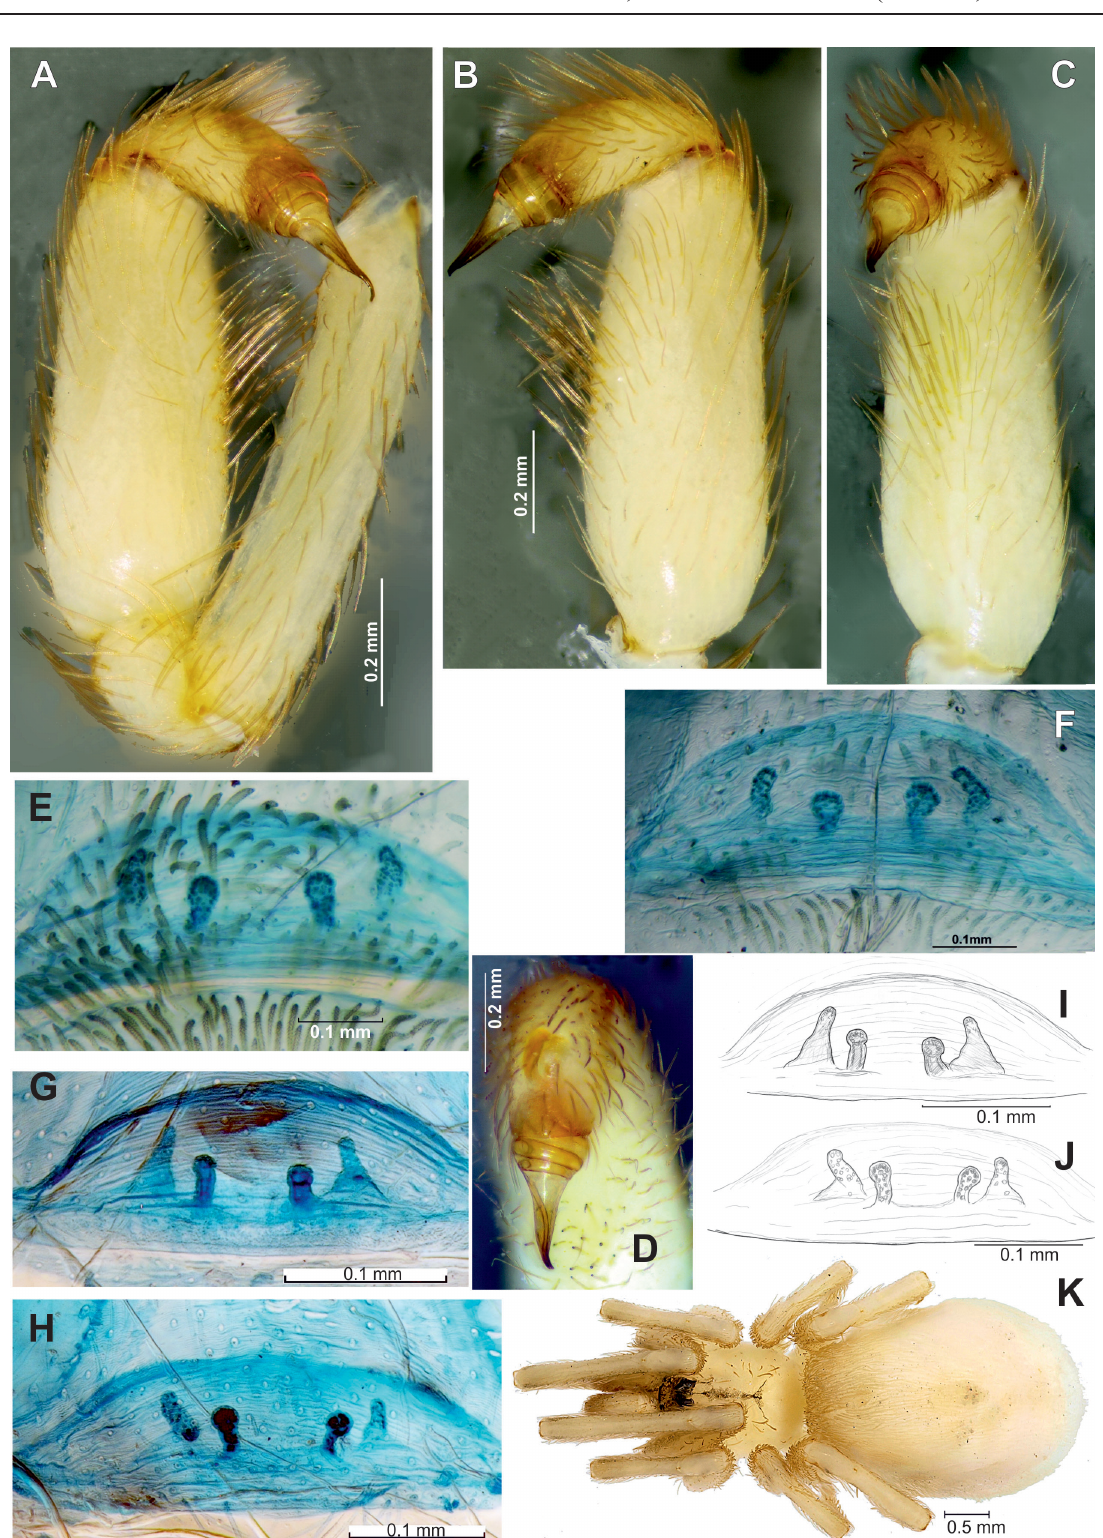
Fig. 35. Copulatory organs and somatic characters of Zaitunia ferghanensis sp. nov., paratype, ♂ from osh ( A – D ) and paratypes, ♀♀ from Djalal-Abad ( E – J ) and Ferghana ( K ). — A . Palp, prolateral. B – D . terminal part of palp, retrolateral, ventral and dorsal. E – J . Endogyne (variants), dorsal. K . Habitus,